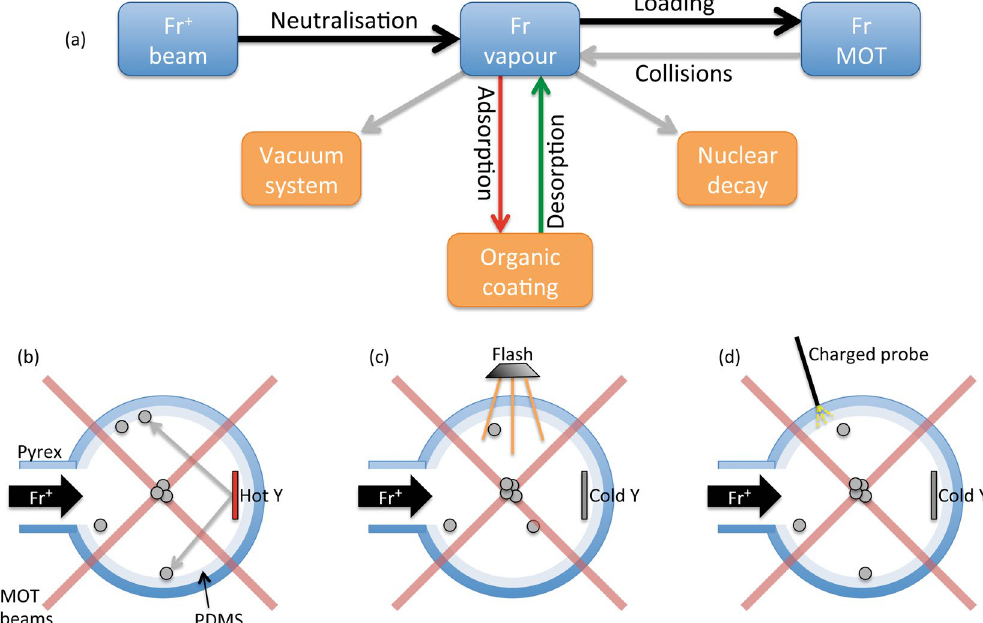
Figure 1. Atomic desorption processes for laser cooling of Francium isotopes. ( a ) Interplay between the source of Fr, the vapour phase, the MOT population and the main sources of loss of atomic population. Adsorption can be effectively contrasted by controlled desorption mechanisms, as discussed in the main text. ( b ) Normal operation loading of the Fr MOT. ( c ) Loading of the Fr MOT with pulsed photodesorption of atoms embedded in the PDMS coating. ( d ) Loading of the Fr MOT with charge transfer-induced atomic desorption. Sketches are not to scale and are shown for illustrative purposes